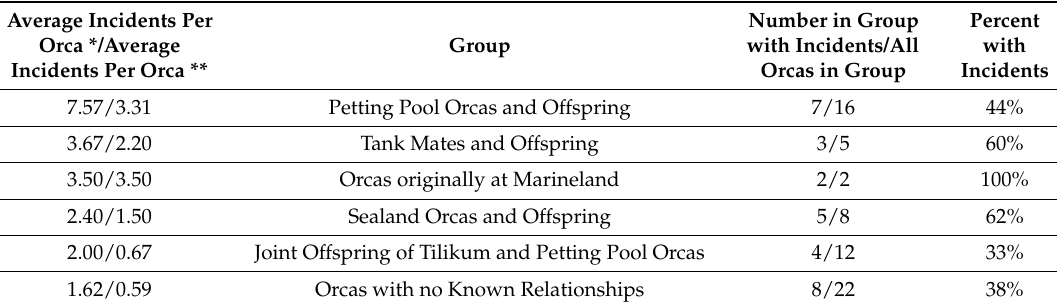
Table 1. Summary of orca incidents by group.